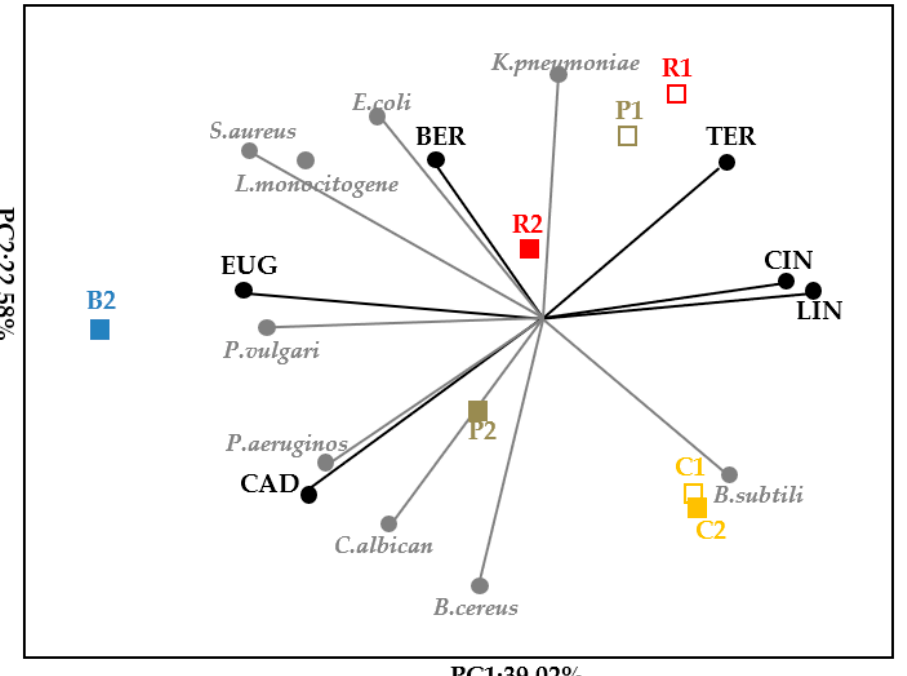
Figure 1. The relationships between major compounds in BEOs and antimicrobial activity depend on basil production factors. (Compounds: LIN, linalool; CIN, 1, 8 ‐ cineole; TER, α‐ terpineol; EUG, eugenol; CAD, epi ‐α‐ cadinol; BER, α‐ trans ‐ bergamotene. Shading nets and harvests: C1 and C2, non ‐ shaded first and second harvest; R1 and R2, red net first and second harvest; P1 and P2, pearl net first and second harvest; B2, blue net second harvest).